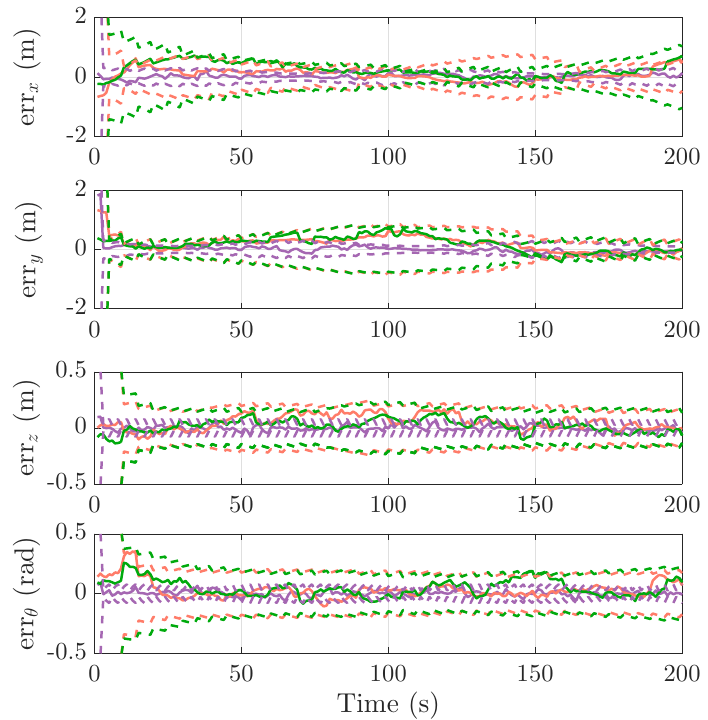
Figure 12. The self-localization errors and covariance of three quadrotors.